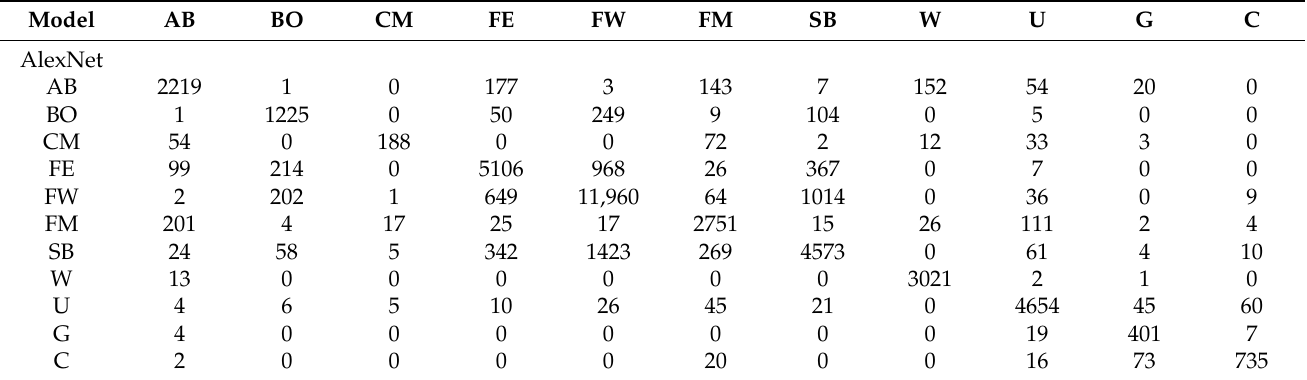
Table 6. Confusion matrix of the Swin Transformer (AB = Aquatic bed, BO = Bog, CM = Coastal marsh, FE = Fen, FM = Freshwater marsh, FW = Forested wetland, SB = Shrub wetland, W = Water, U = Urban, G = Grass, C =